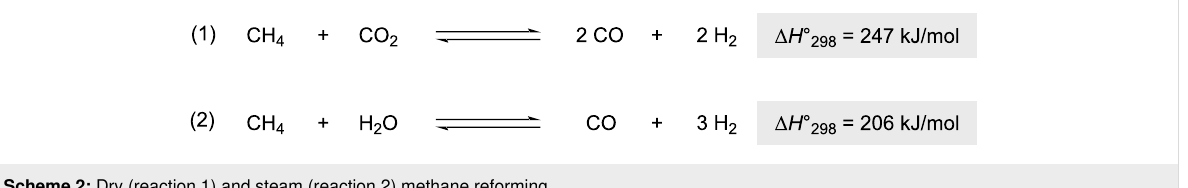
Scheme 2: Dry (reaction 1) and steam (reaction 2) methane